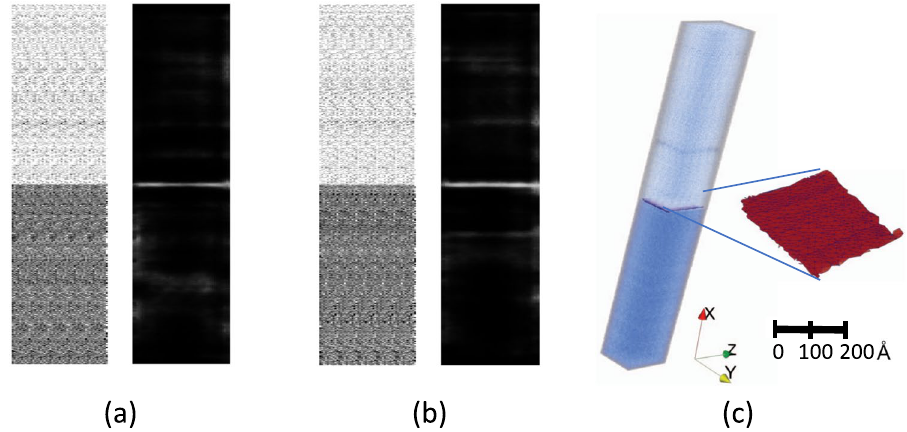
Figure 1. Two- and three-dimensional edge detection map in a synthetic Co-Al alloy generated from MD simulation. ( a ) Concentration space (left) and edge detection map (right) of a slice along the Y-direction, ( b ) Concentration space (left) and edge detection map (right) of a slice along the Z-direction, ( c ) edge surface obtained by merging the edges in the Y- and Z-directions.